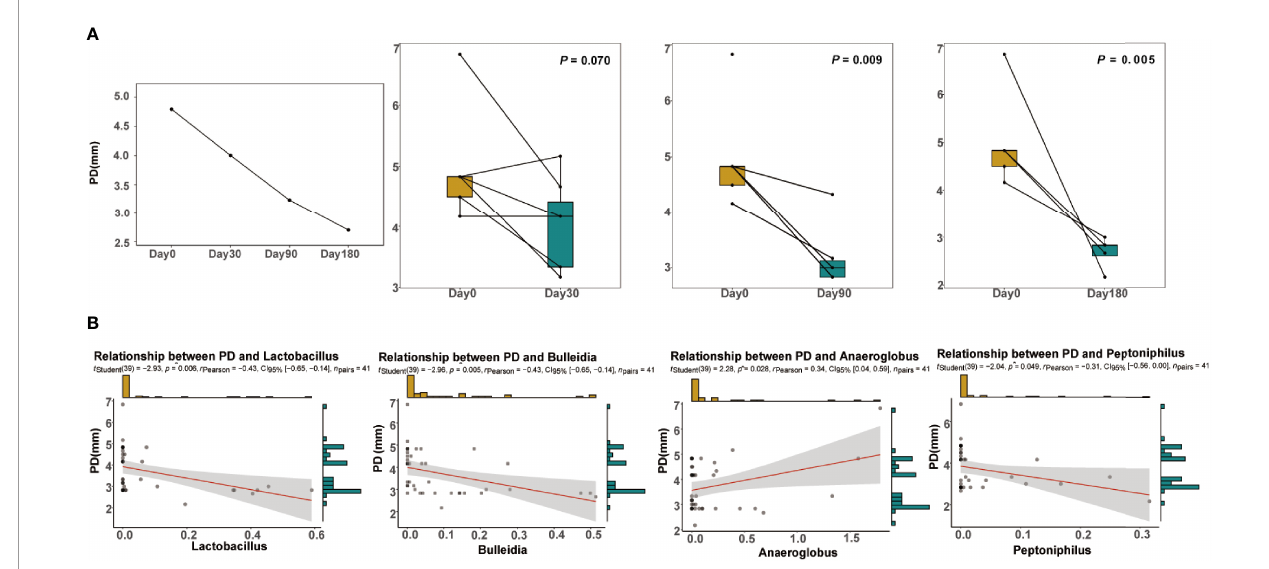
FIGURE 6 | Clinical information. (A) Changes in the average probing depth (PD) over time at the four time points. Signi fi cance was measured using Wilcoxon rank- sum test between each time point and before treatment ( P < 0.05). (B) The linear regression of PD against the relative abundance of the genera Lactobacillus , Bulleidia , Anaeroglobus , and Peptoniphilus . The 0.95 con fi dence interval is